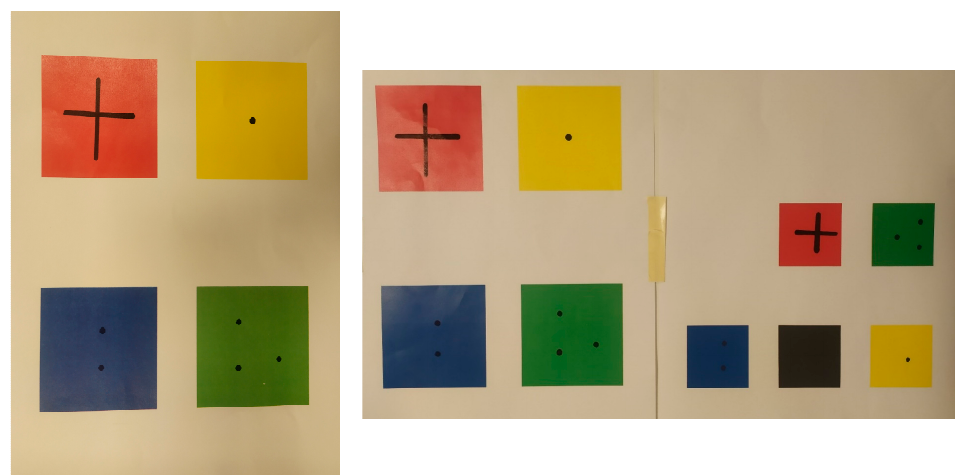
Figure 10. The proof of task competition. Testbed—sample 1, Testbed—sample 2.